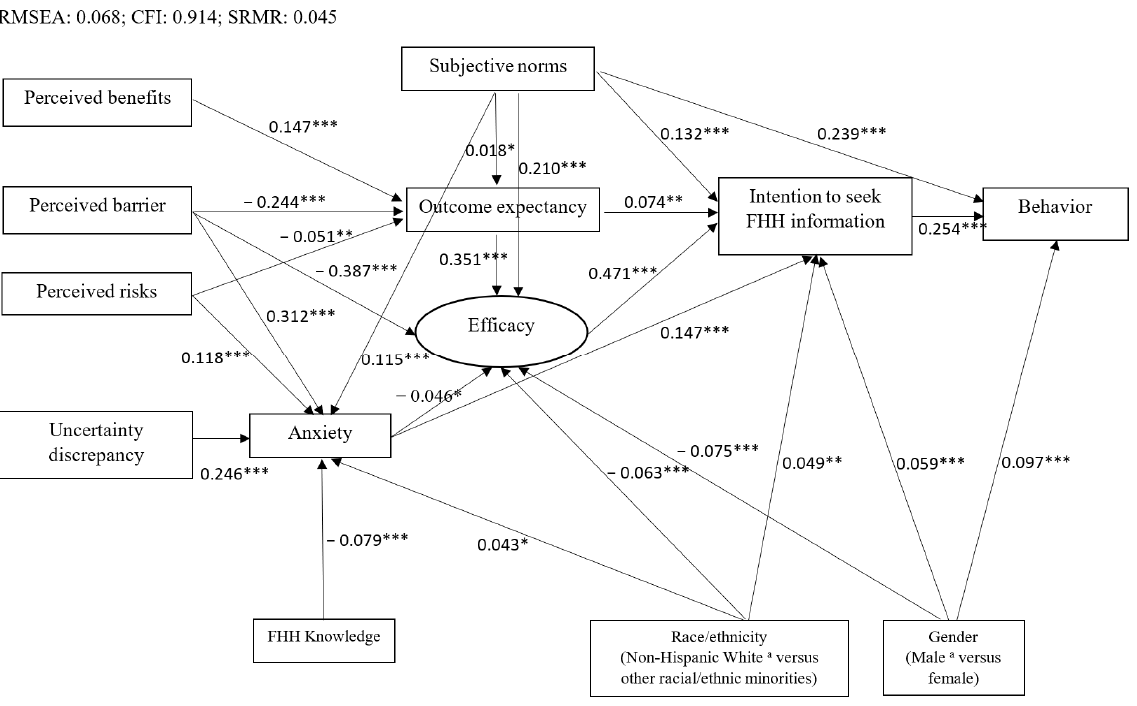
Figure 2. SEM model for FHH information seeking behavior among college students. p < 0.001 ***, p < 0.005 **, p < 0.05 *. The figure only presented the statistically significant associations (solid lines) and standardized coefficients. a Reference group. SEM: Structural equation modeling; FHH: family health